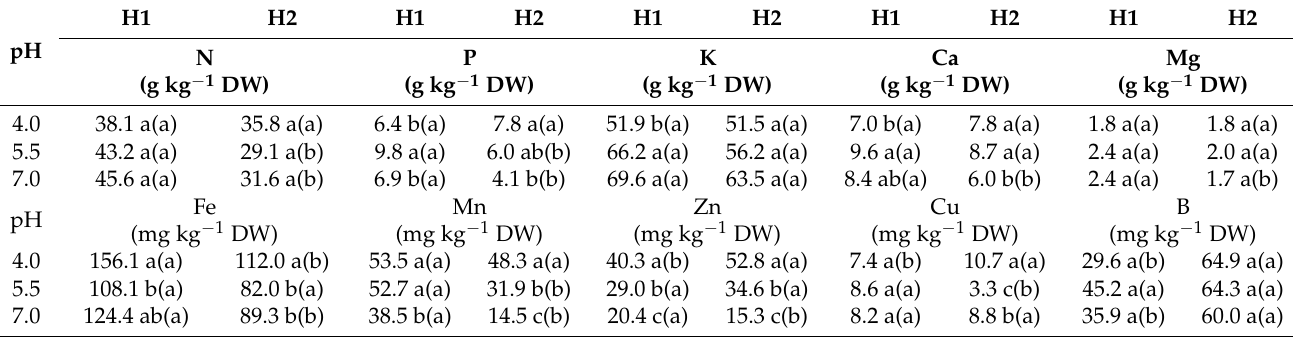
Means in columns followed by the same letter do not differ significantly ( p ≤ 0.05, L.S.D. test). Means in the same row followed by the same letter in parenthesis do not differ significantly ( p ≤ 0.05, T -test). DW: dry